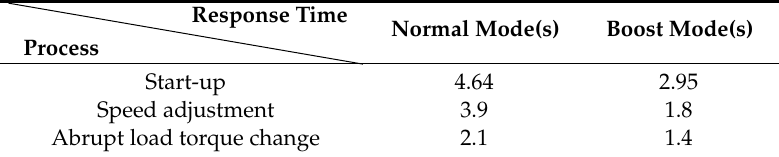
Table 3. The dynamic response time in different processes.